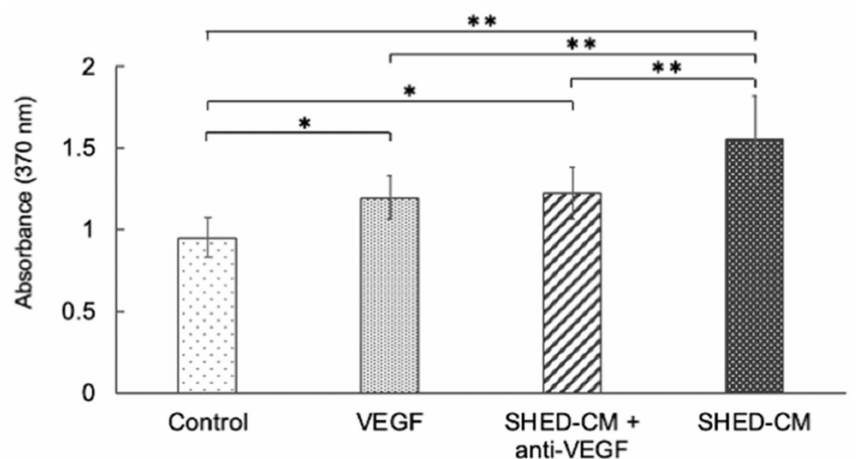
Figure 1. Effect of VEGF-A in SHED-CM on the proliferative ability of HUVECs. The cells in the SHED-CM group exhibited significantly higher proliferative ability than those in the SHED-CM + anti- VEGF-A neutralizing antibody-supplemented (hereafter termed SHED-CM + anti-VEGF-A), VEGF-A, and control groups. Cells in the SHED-CM + anti-VEGF-A and VEGF-A groups showed significantly higher proliferative ability than those in the control group. ( n = 12, ** p < 0.01, * p < 0.05). SHED-CM, human deciduous dental pulp-derived mesenchymal stem cell-derived culture supernatant; VEGF-A, vascular endothelial growth factor-A; HUVECs, human umbilical vein endothelial